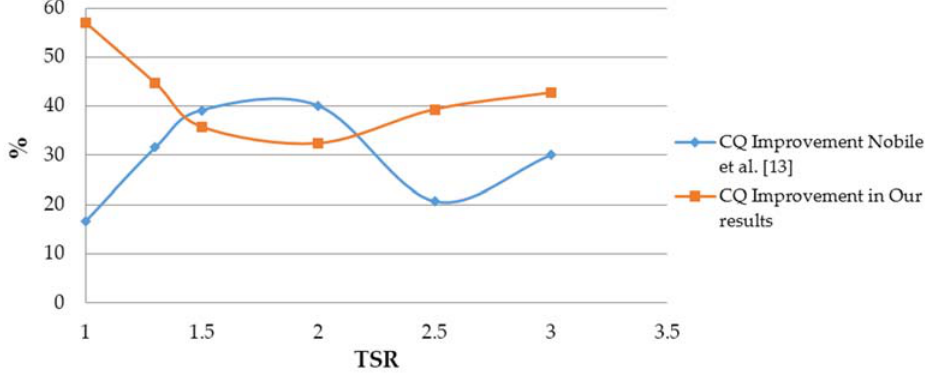
Figure 33. Comparison of the C Q average improvement in this study with the Nobile et al. [13].